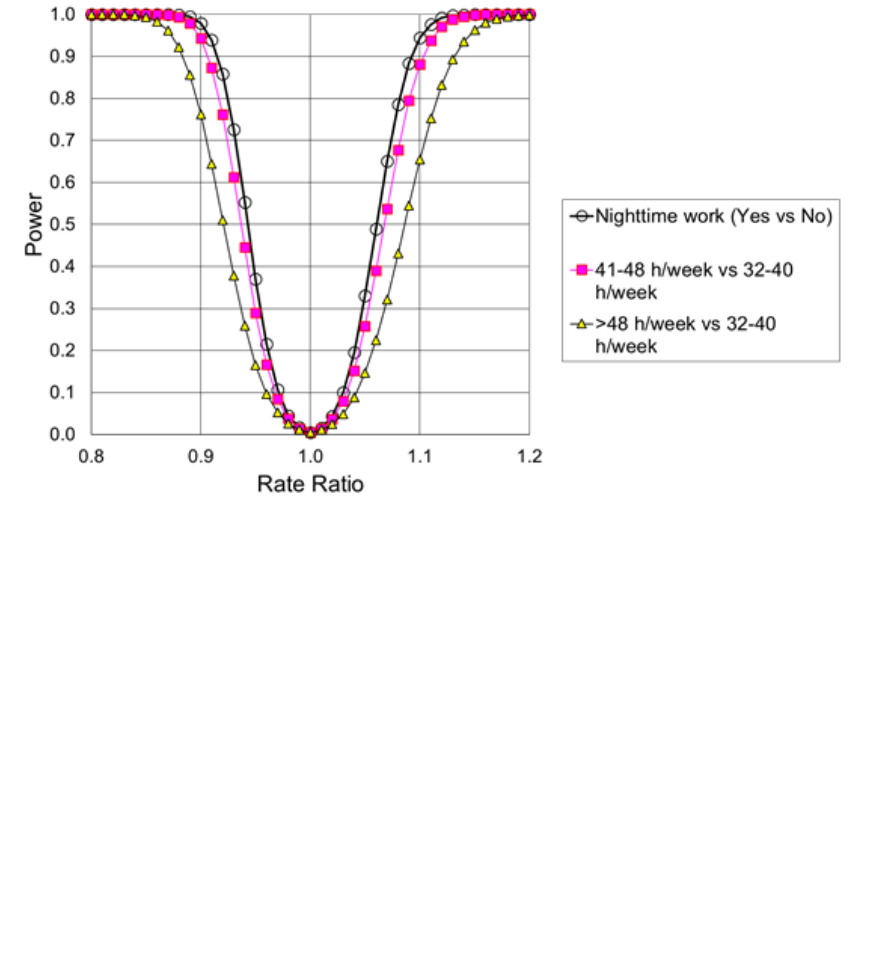
Figure 4. Power to detect main effects of night shifts and long working hours on the rates of new cases of psychotropic drug use, as a function of underlying rate ratios ( α